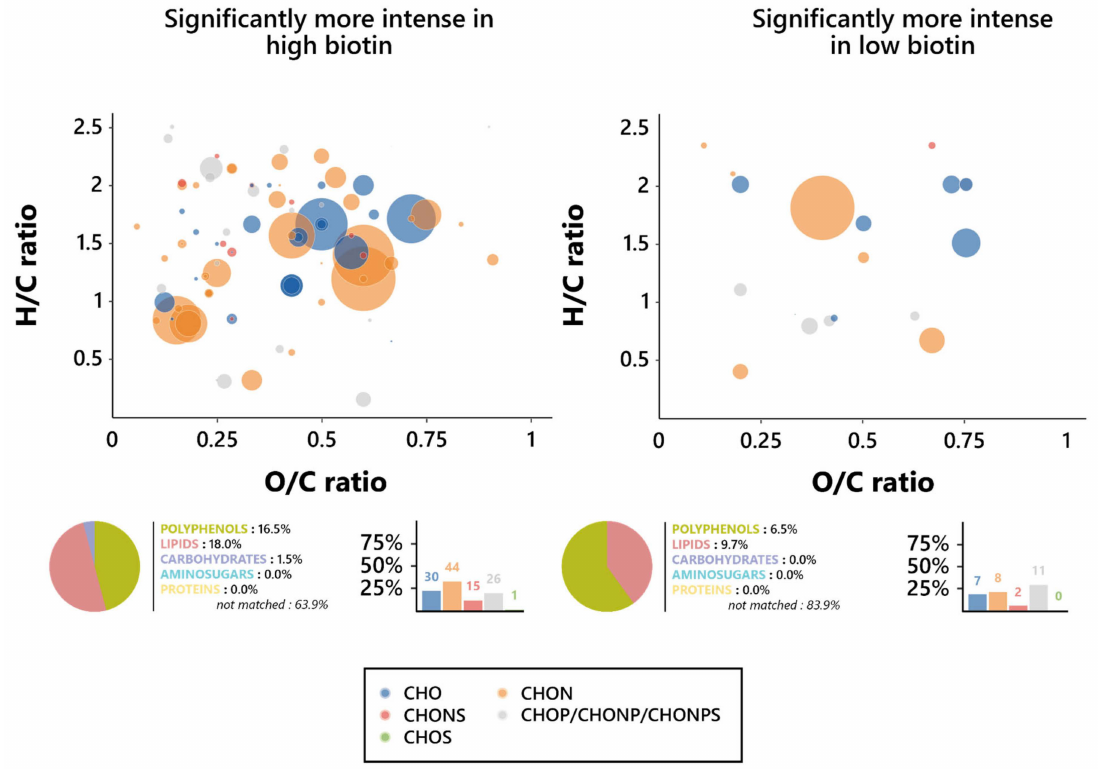
Figure 4. Metabolomic foot-printing of S. cerevisiae grown in high or low biotin conditions based on LC-MS-MS untargeted analysis data. Van Krevelen diagrams based on the H/C and O/C atomic ratios for the significantly more intense features (extracted through ANOVA; p < 0.01), histogram proportion of their elemental compositions, and pie chart distribution of the predicted families for these biomarkers in high biotin conditions ( left , 133 markers) and low biotin conditions ( right , 31 markers). The point size indicates the relative intensity of the extracted